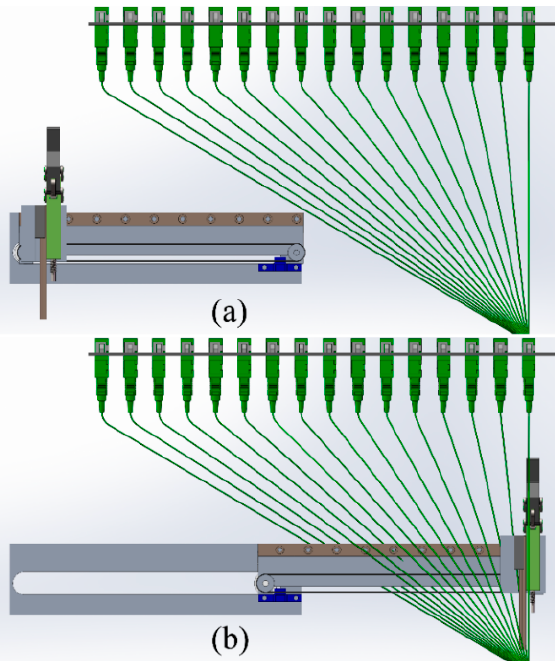
Figure 12. Working range diagram of the rapier robot. ( a ) Full contraction state; ( b ) full extension state.